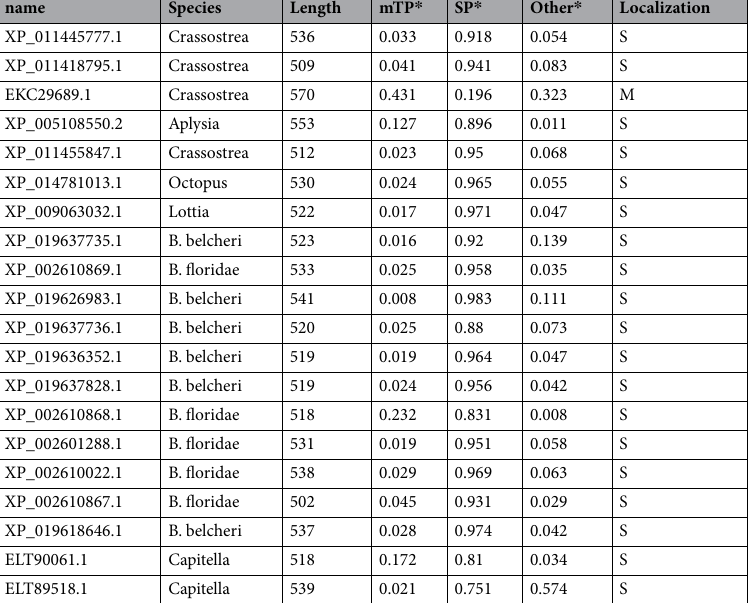
Table 1. Signal peptide prediction with TargetP for BCOL proteins. * “mTP”, “SP”, “other” are TargetP scores. The actual prediction is in column “Localization” and the characters in this column have the following